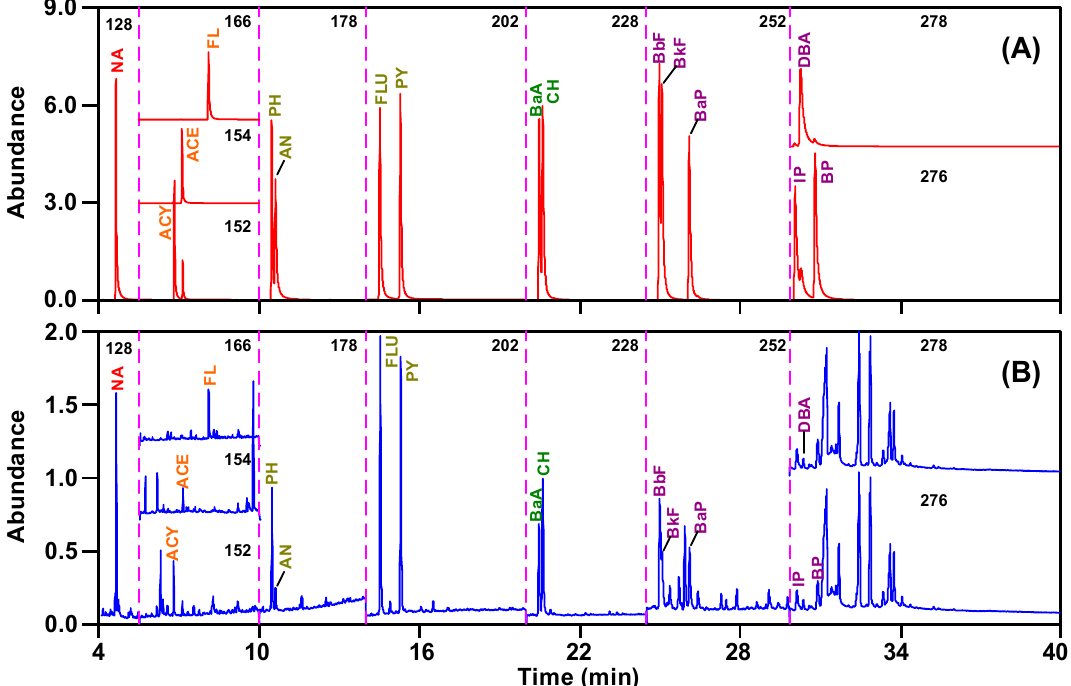
Figure 1. GC-MS selected quantification ion chromatograms of 16 PAHs in ( A ) standard mixture of 16 PAHs and ( B ) the WW2 sludge sample. The definitions of compound abbreviation see Table 2.